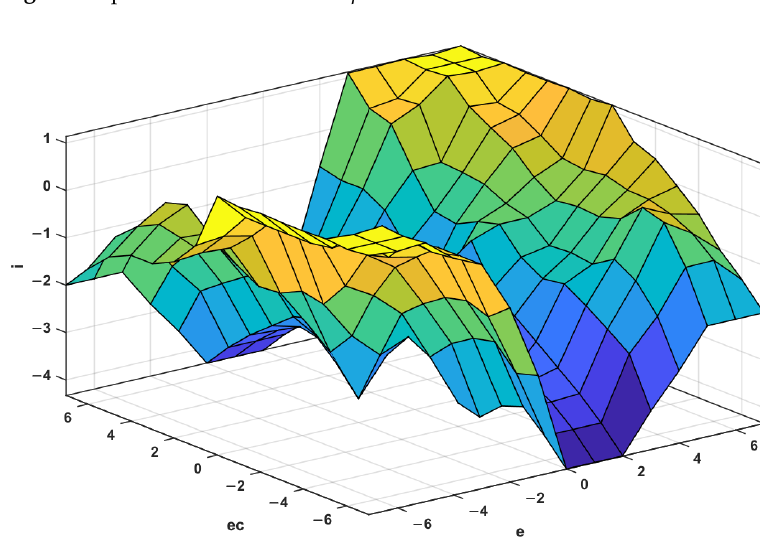
Figure 9. Spatial distribution of △ Ki. Table 2. ∆ Kp fuzzy inference rule